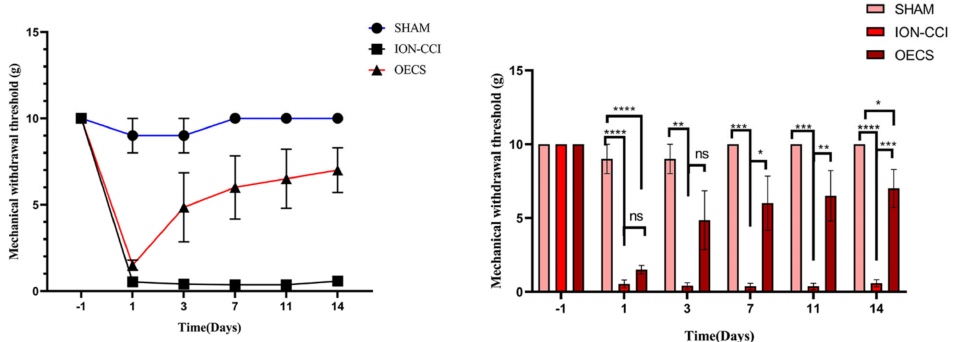
Figure 3. Mechanical withdrawal threshold (MWT). After the establishment of the chronic infraorbital nerve ligation injury model, the mechanical facial pain threshold in the sham group did not change significantly from the threshold value before the surgery was performed. Behavioral changes in the OEC group were noticeable from Day 3; but the changes were less noticeable in the ION-CCI group. The MWT was significantly lower in the ION-CCI group than the sham group ( p < 0.05) on Day 14. However, the MWT was significantly higher in the OECs group than the ION-CCI group ( p < 0.05) but still lower than the sham group ( p < 0.05). The data were collected and evaluated by an independent team. Data are expressed as mean ± SEM ( n = 4 per group, one-way analysis of variance followed by the least significant difference post hoc test). * Indicates p < 0.05; ** indicates p < 0.01; *** indicates p < 0.001; **** indicates p < 0.0001. ION-CCI, chronic constrictive injury of infraorbital nerve; MWT, mechanical withdrawal threshold; OEC, olfactory ensheathing cell; SEM, standard error of the